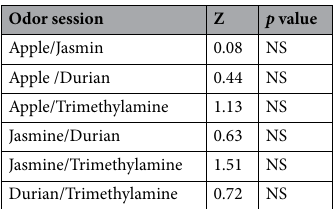
Table 7. Wilcoxon tests: comparisons of hunger level between the different odor sessions. Non-significant results are noted as NS.